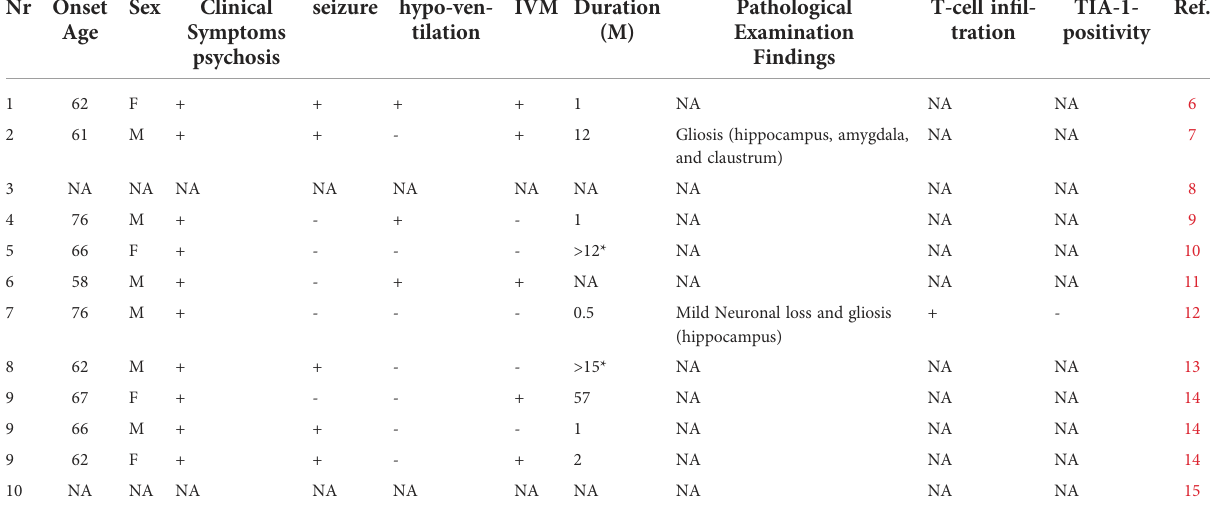
TABLE 1 Clinical features of cases of encephalitis complicating SCLC with NMDAR